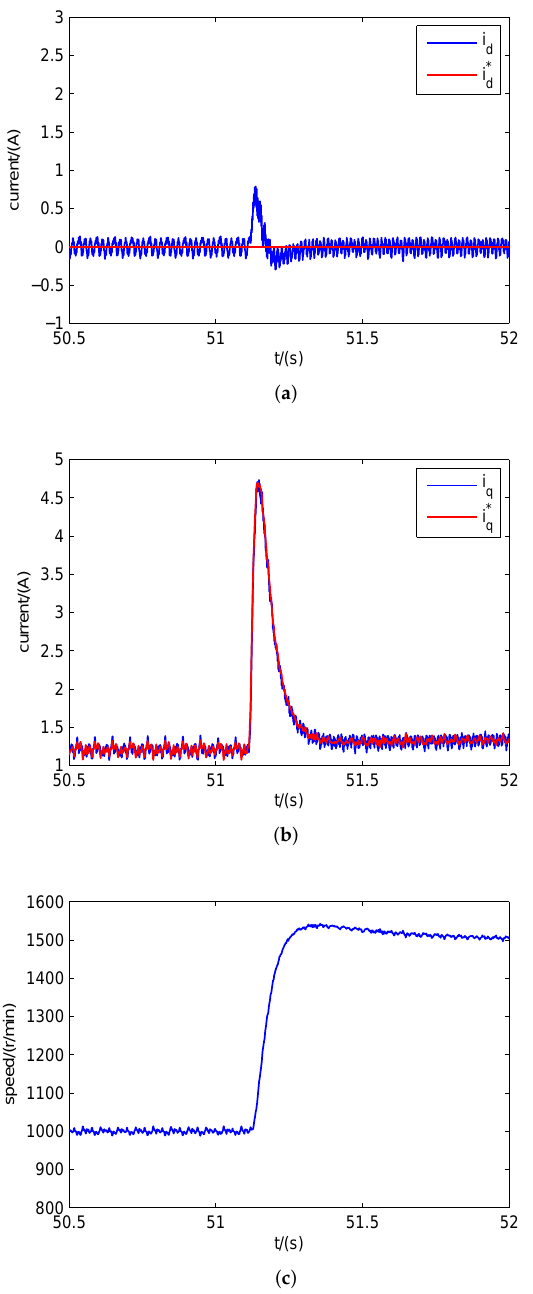
Figure 12. Experimental results with the increase of reference speed: ( a ) d-axes current; ( b ) q-axes current; and ( c ) speed